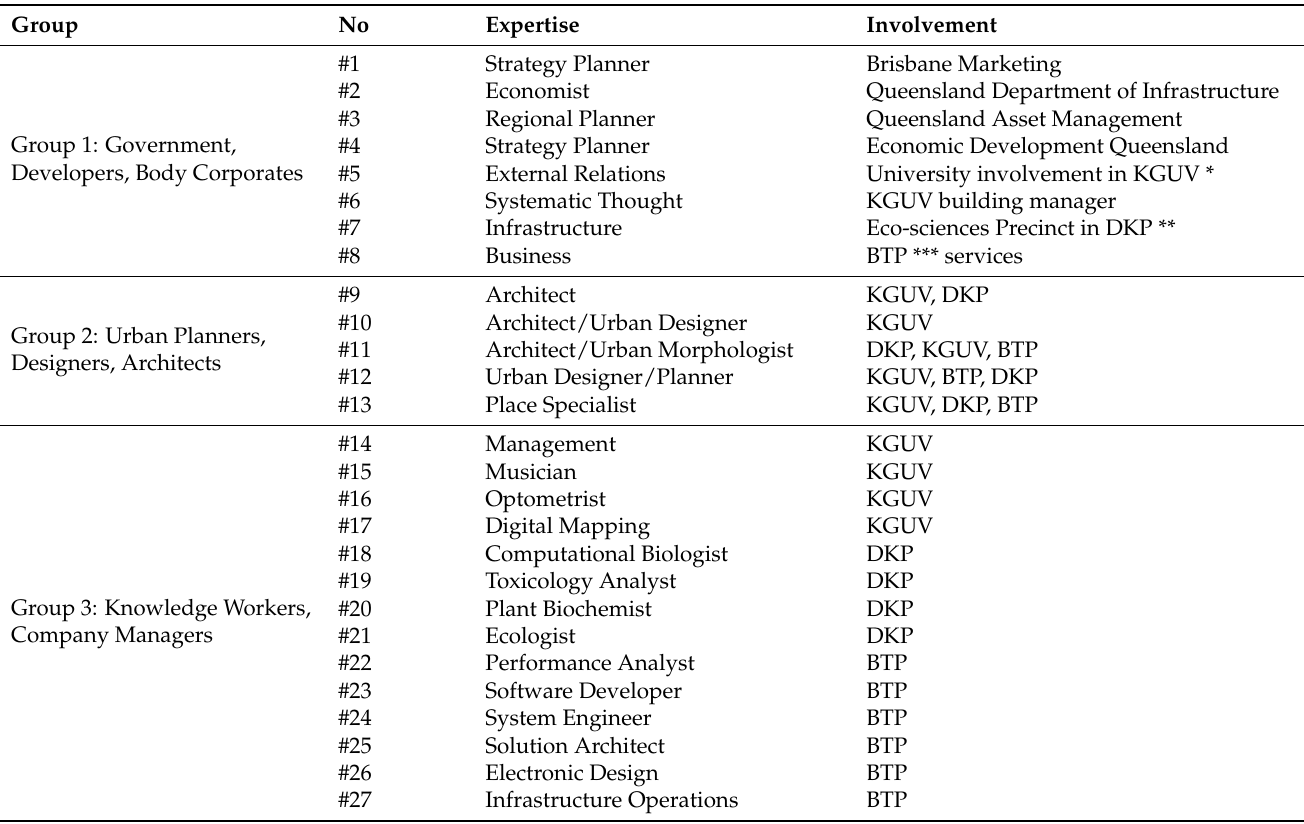
Table 2. Interviewee expertise and